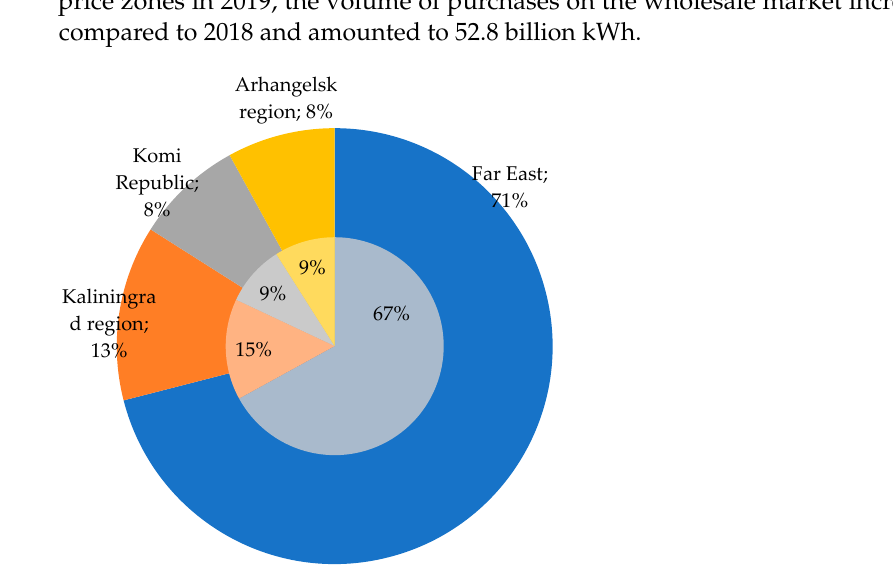
Figure 9. The structure of the purchase of electricity on the wholesale market in non-price zones in 2018 (internal) and 2019 (external), %. Source: own results.